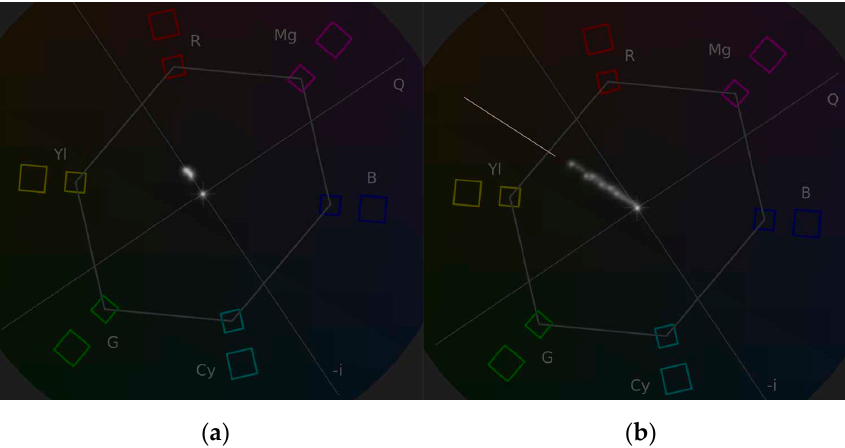
Figure 10. Colours are presented in the vectorscope as dots. ( a ) Dots are aligned on the “skin tone line” presenting the reference value of the skin tone colours, and ( b ) dots presenting colours in the image if the reference colours were captured on the Medicam 1000s camera.